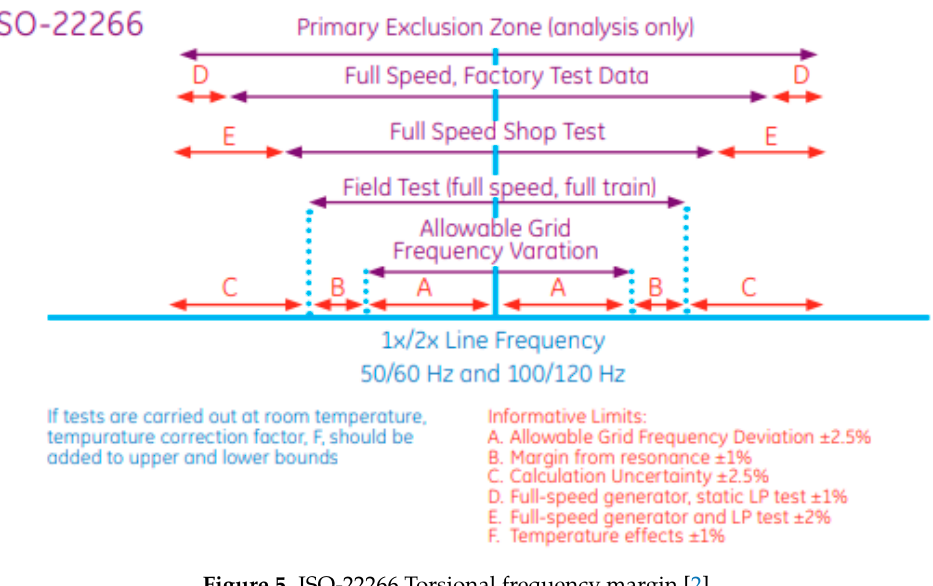
Figure 5. ISO-22266 Torsional frequency margin [2].